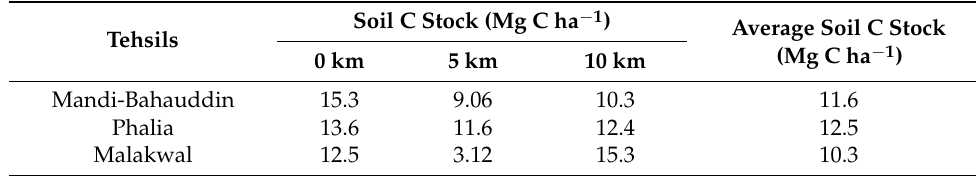
Table 6. Average Soil Organic Carbon Stock.